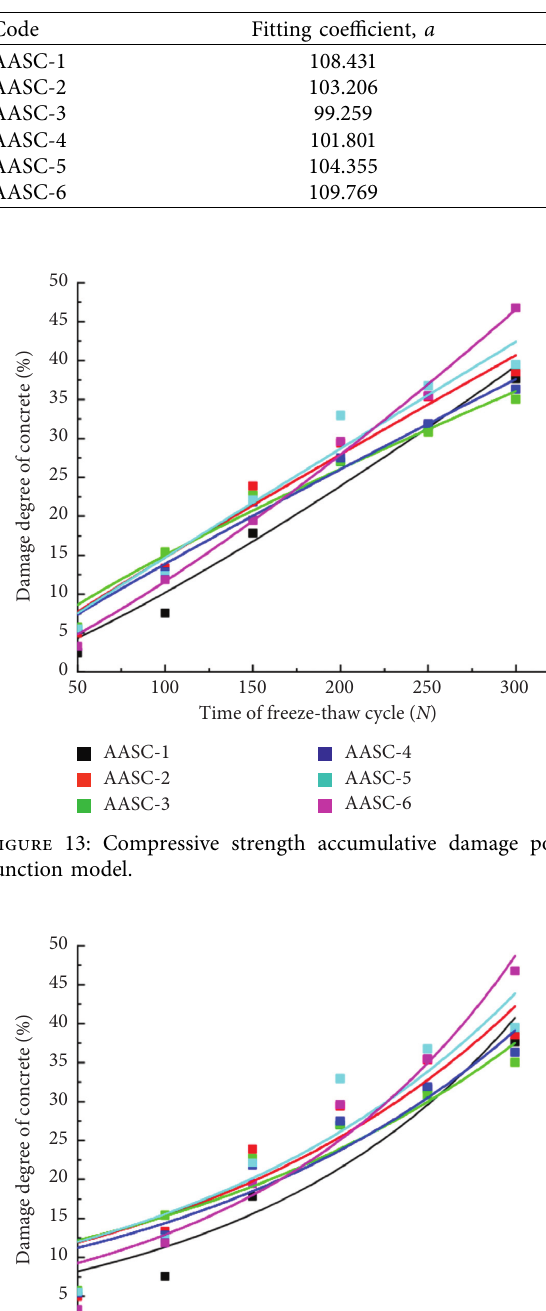
Table 9: Compressive strength attenuation exponential function and pertinence coefficient.